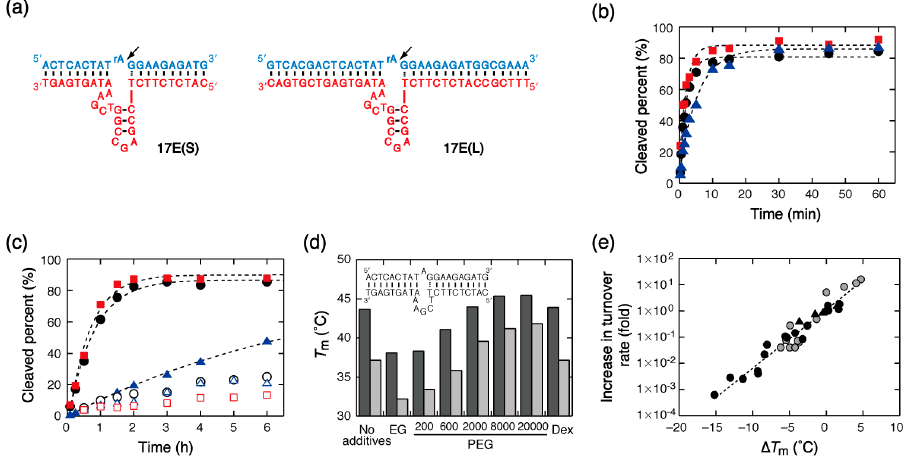
Figure 2. ( a ) Structures of the 17E DNAzymes and their substrates used in this study. The cleavage sites are indicated by arrowheads. ( b ) Kinetic traces for substrate cleavage catalyzed by 17E(L) under single ‐ turnover conditions in the presence of 10 mM MgCl 2 and in the absence (black circles) and presence of PEG8000 (red squares) or PEG200 (blue triangles). ( c ) Kinetic traces for substrate cleavage catalyzed by 17E(S) (closed symbols) and 17E(L) (open symbols) under multiple ‐ turnover conditions in the presence of 10 mM MgCl 2 and in the absence (black circles) and presence of PEG8000 (red squares) or PEG200 (blue triangles). ( d ) T m values of the DNA structure presented in the inset evaluated in solutions containing 10 mM MgCl 2 (black) or 1 mM MgCl 2 (gray), with and without EG, PEGs, or Dex. ( e ) Plot of the increments of the turnover rate of the 17E(S) ‐ catalyzed reaction against Δ T m in the presence of 10 mM MgCl 2 (black) or 1 mM MgCl 2 (gray), excluding the data for reactions characterized by a very slow rate. The data obtained using 10% or 30% PEG solutions (PEG8000 and PEG200) and EtOH solution are also included (triangles). The correlation coefficient of a linear fit is 0.97. Table 2. Fold increase in the rate of the 17E(S) ‐ catalyzed turnover reaction in mixed solutions over the rate in the absence of organic additives.